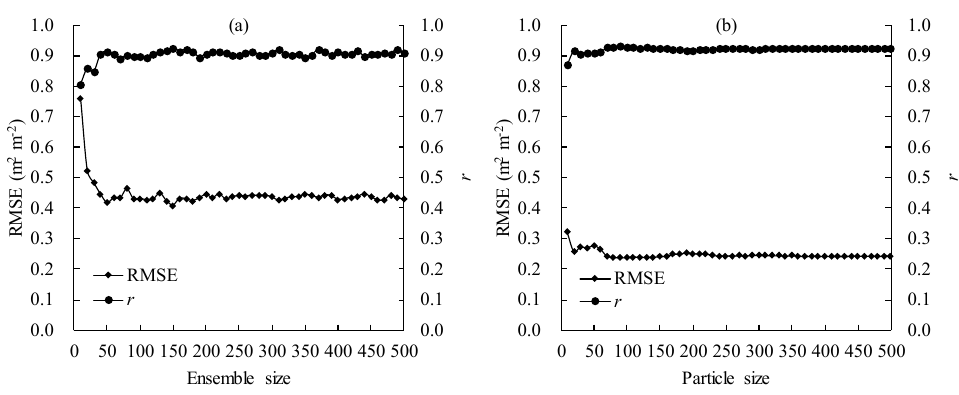
Figure 6. Performance of data assimilation for different ensemble sizes ( a ) and particle sizes ( b ).